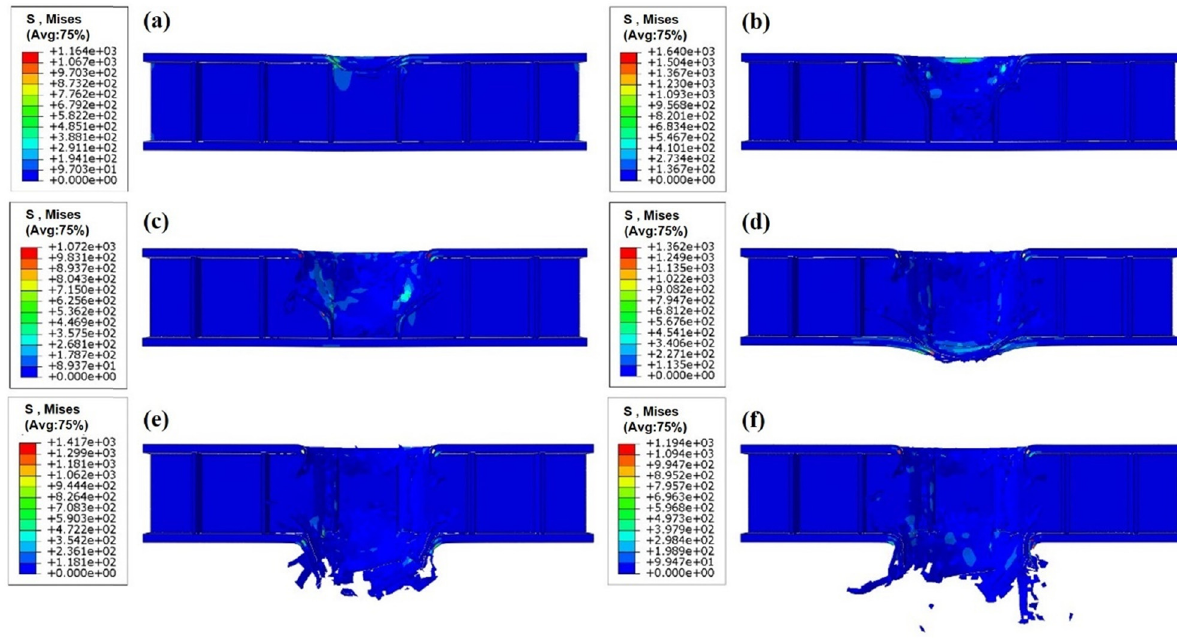
Figure 11: Impact damage expansion process of grid sandwich structure Q - 8 - 10. ( a ) t = 0.25 ms, ( b ) t = 0.75 ms, ( c ) t = 1.25 ms, ( d ) t = 1.75 ms, ( e ) t = 2.25 ms, and ( f ) t = 2.75